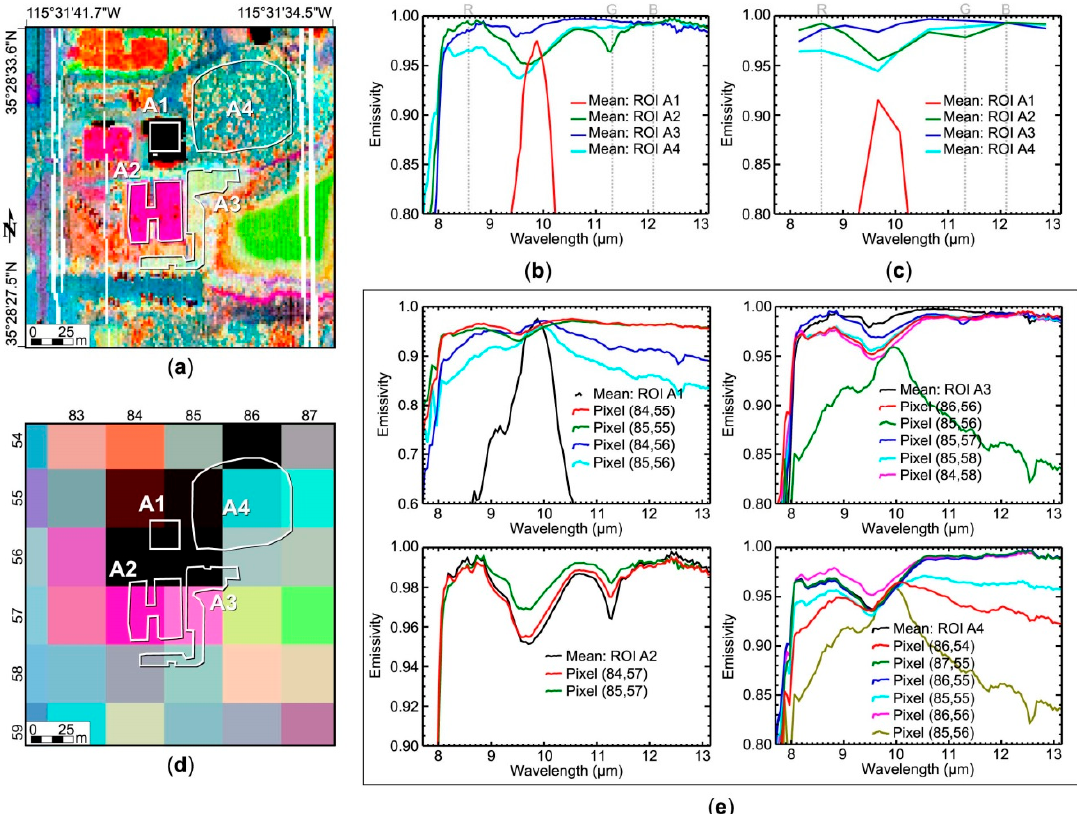
Figure 18. Detailed examination of a subset of the Mako emissivity data: ( a ) outlines of selected regions of interest (ROIs) on the false color composite image with bands 8.59/11.32/12.10 µm displayed as red/green/blue; ( b ) mean emissivity spectra of the ROIs; ( c ) mean emissivity spectra of the ROIs convolved to the spectral response functions of the MODIS/ASTER Airborne Simulator (MASTER) longwave infrared bands; ( d ) ROI outlines on Mako data resampled to the pixel size of our MASTER data set; ( e ) mean emissivity spectrum of each ROI plotted with the spectra of the new resampled pixels to which it contributes .